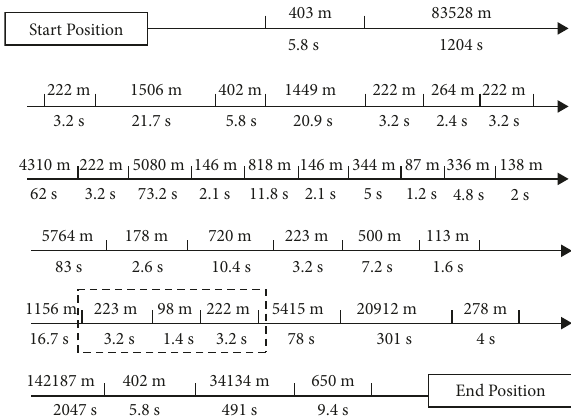
Figure 1: Layout scheme of BEJs in the high-speed railway